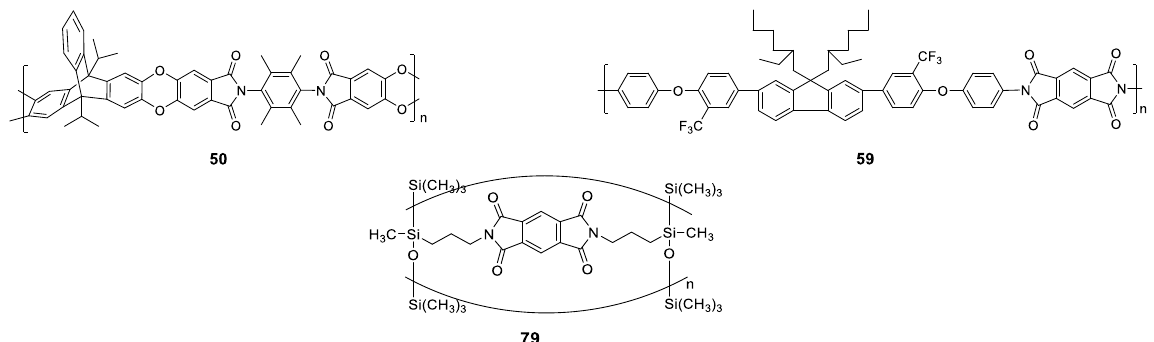
Figure 9. Plots of oxygen permselectivity through polyimides (PI), showing the highest α at each P O 2 reported in the literature in 2020. For the data and categorization of the plots, see Table 7, and for the chemical structures of the polymers in the plots, see Chart 6.